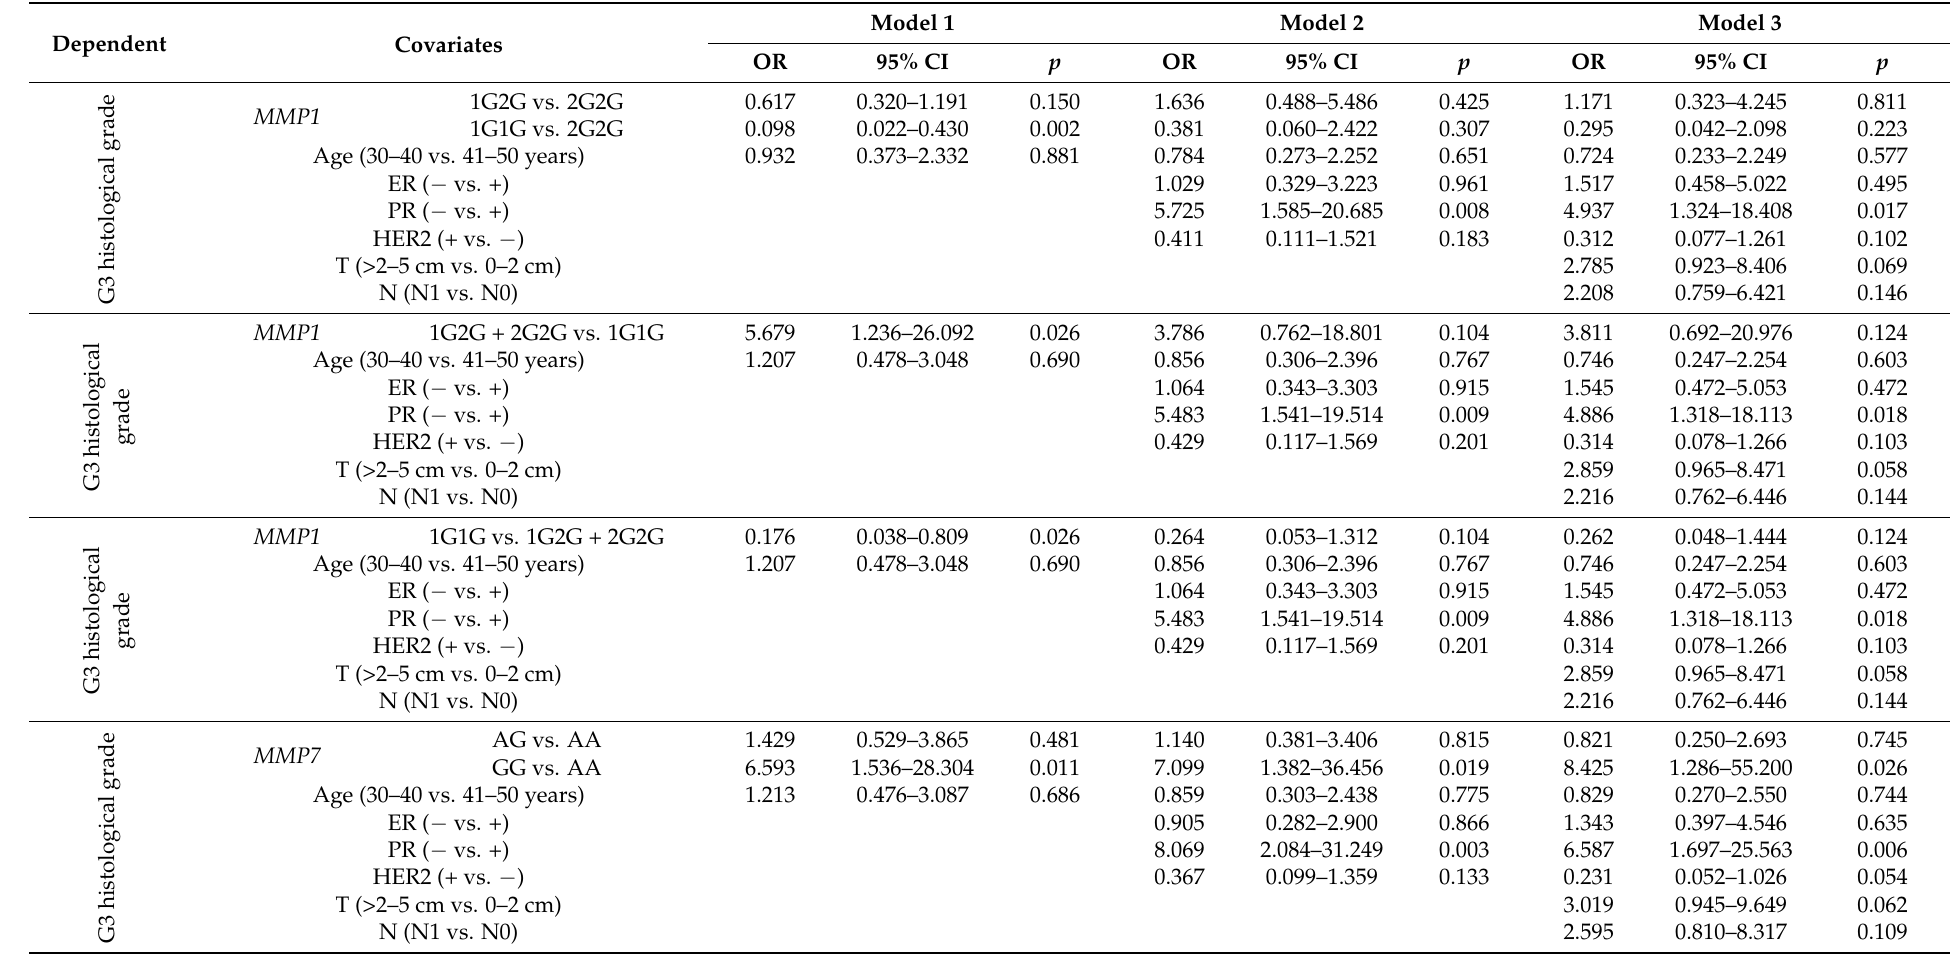
Table 5. Multivariate logistic regression analysis for significant positive associations assessed in the univariate